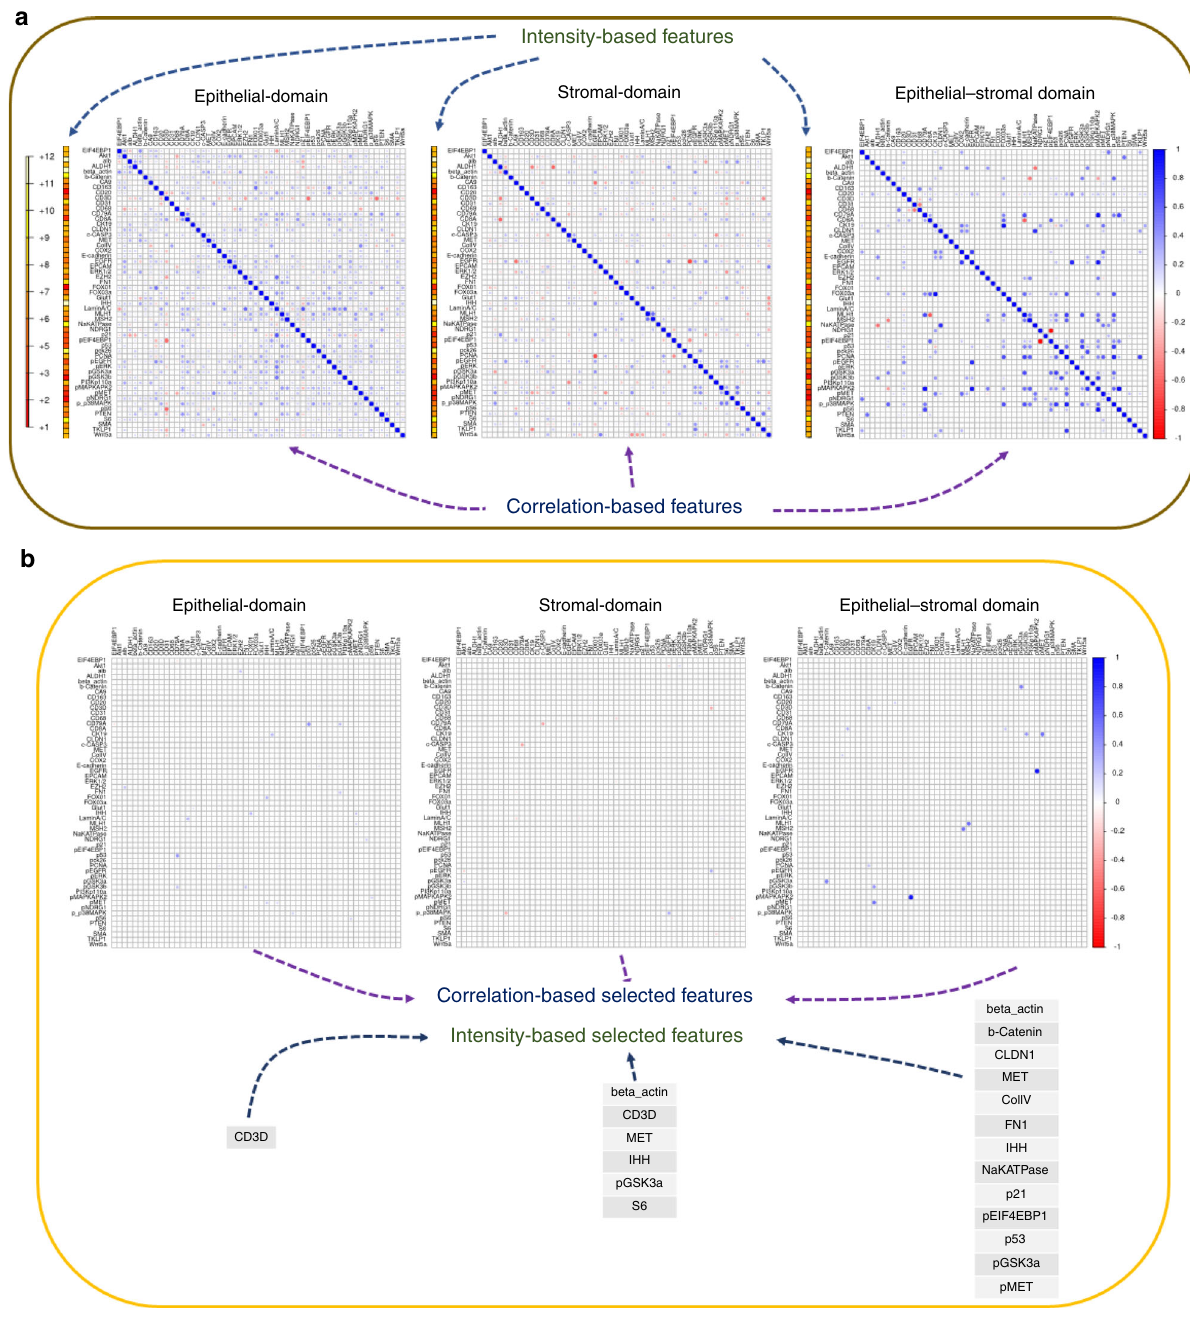
Fig. 2 SpAn domain-speci fi c feature selection. a Individual mean protein-expression intensity pro fi le depicted as a vector and pairwise Kendall rank- correlations between protein expressions — visualized as a matrix for each of the three spatial domains. The protein expressions are shown in log scale. To prevent inclusion of false-positive protein expression, only intensities above the 85th percentile were considered as expressions and used to compute the correlations (see Methods). b Features, including both expressions and correlations, selected by SpAn based on L1-penalized Cox regression used for model selection. The selected features were consistently concordant at the 90% level with the recurrence